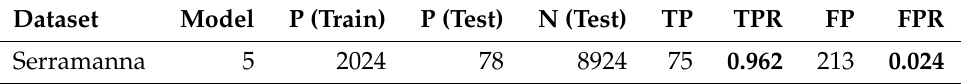
Table 4. Experiment 3: True positive rate (recall) for hotspot detection in thermal images. The R-CNN model was trained using an aggregated dataset from different PV sites and evaluated on a dataset from one particular PV site for which examples were also present in the training